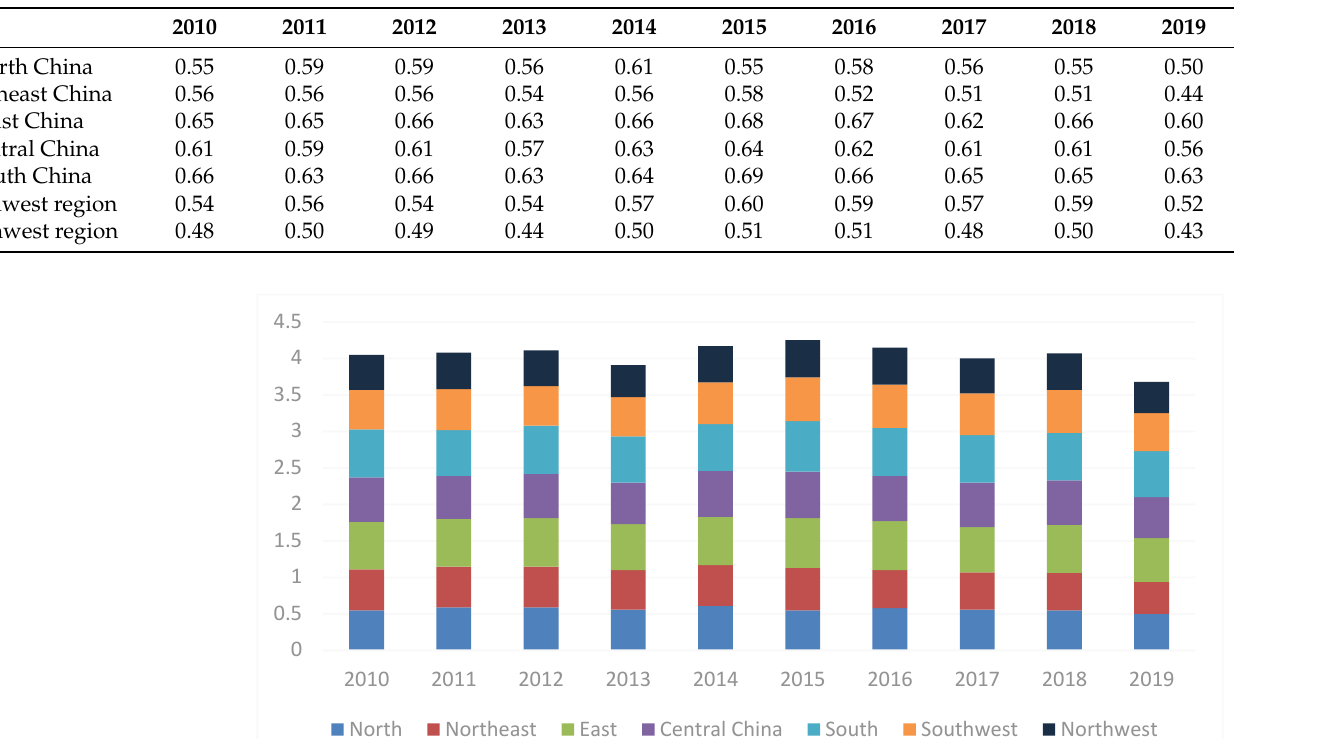
Table 6. Level of coupling coordination between logistics and ecological environment in seven regions in China.